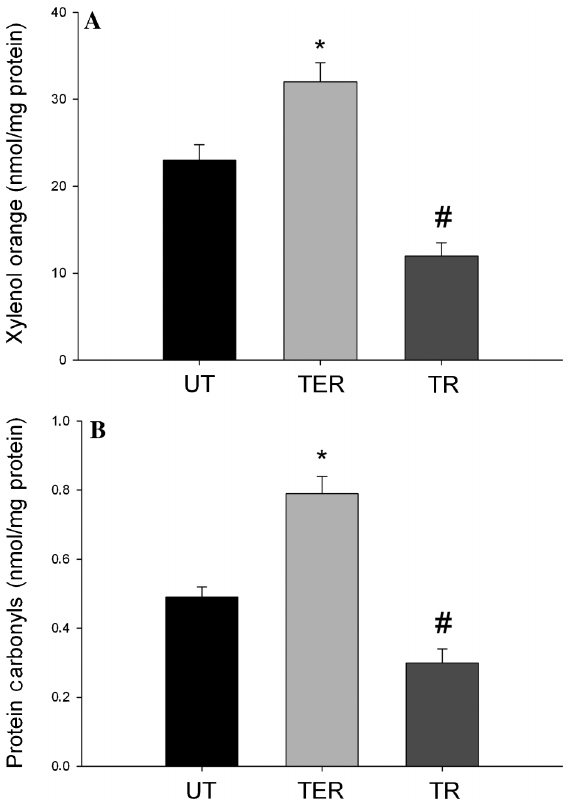
Figure 2. The level of oxidative damage [ferrous oxidation- xylenol orange ( A ) and protein carbonyls ( B )] was determined in skeletal muscle (red portion - quadriceps) 48 h after the last session of training. The animals were divided into 3 groups (N = 6 each): UT = untrained; TER = trained eccentric running (16 ˚ ); TR = trained running (0 ˚ ). Data are reported as means ± SE. *P , 0.05 compared to the UT group; # P , 0.05 compared to the UT and TER groups (Tukey HSD